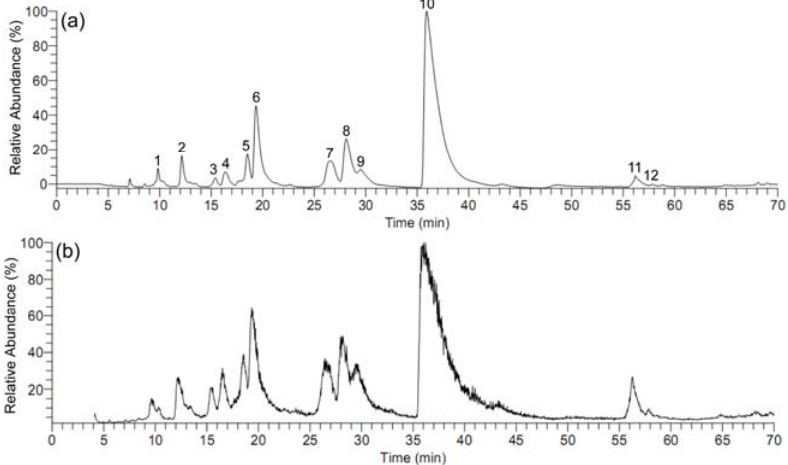
Figure 1. The HPLC-DAD chromatogram (a) and the total ion current (TIC) chromatogram (b) of the dichloromethane extract of C. yanhusuo